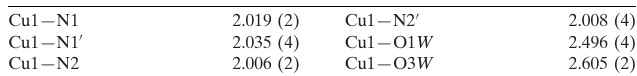
Selected bond lengths (A˚ ).